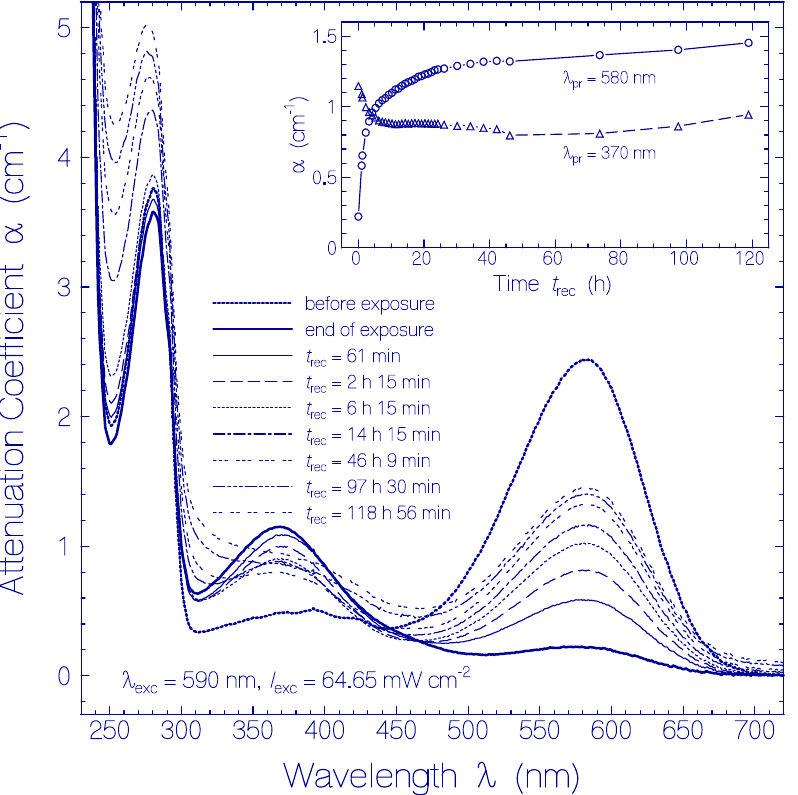
Figure 2. Attenuation coefficient spectra recovery of QuasAr1 in pH 8 Tris buffer after light exposure with LED 590 nm (input excitation intensity I exc = 64.65 mW cm − 2 ) for an exposure time of t exc = 25 min